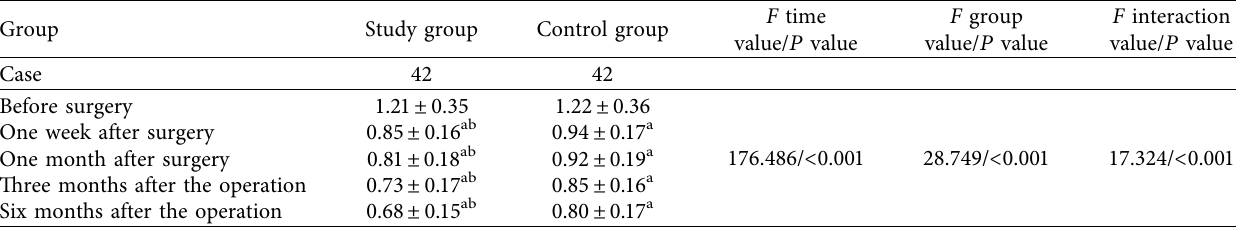
Table 2: Comparison of logMAR BCVA between two groups at diferent time points ( x ± s ).